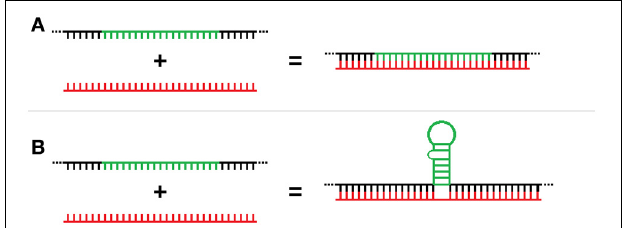
FIGURE 1 | Trans-acting 3-way junction model. (A) Representation of traditional miRNA-mRNA double stranded duplex formation as compared to (B) the proposed trans 3-way junction sxRNA structure, which would result from the splinting of a miRNA discontinuously across the flank region of the mRNA located at the base of a stem-loop